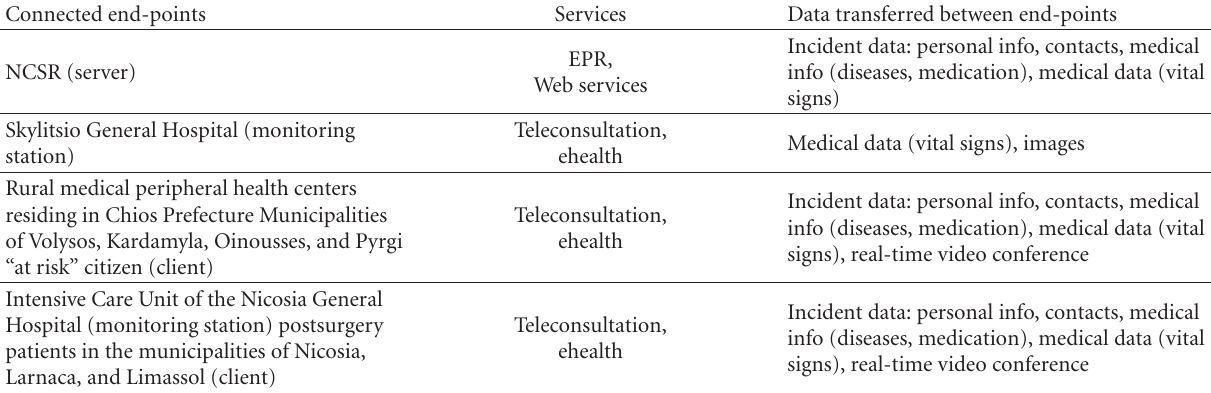
Table 1: Services provided per pilot